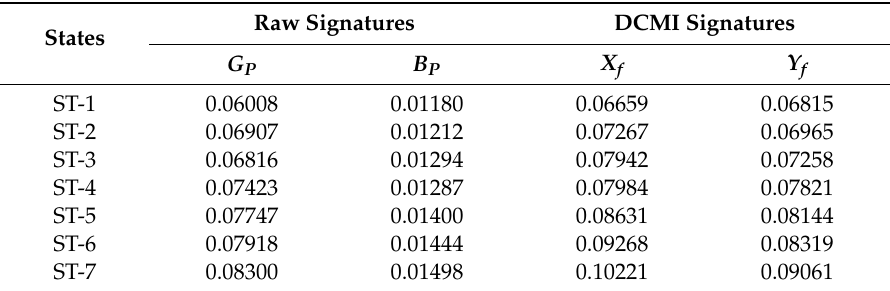
Table 6. RMSD based on raw signatures and DCMI signatures of specimen-2.